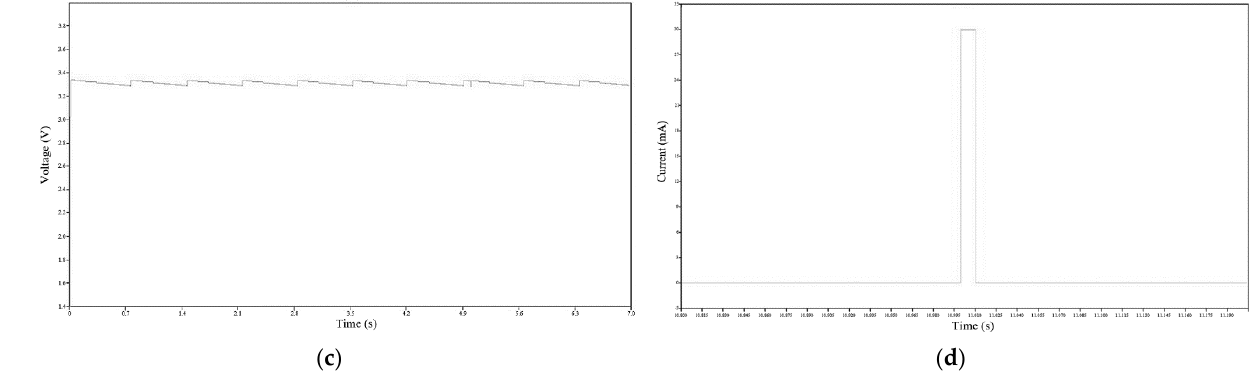
Figure 3. Voltage and current characteristics according to mechanical force: ( a ) input voltage of oscillating piezoelectric module; ( b ) input current of oscillating piezoelectric module; ( c ) output voltage of oscillating piezoelectric module; ( d ) output current of oscillating piezoelectric module.